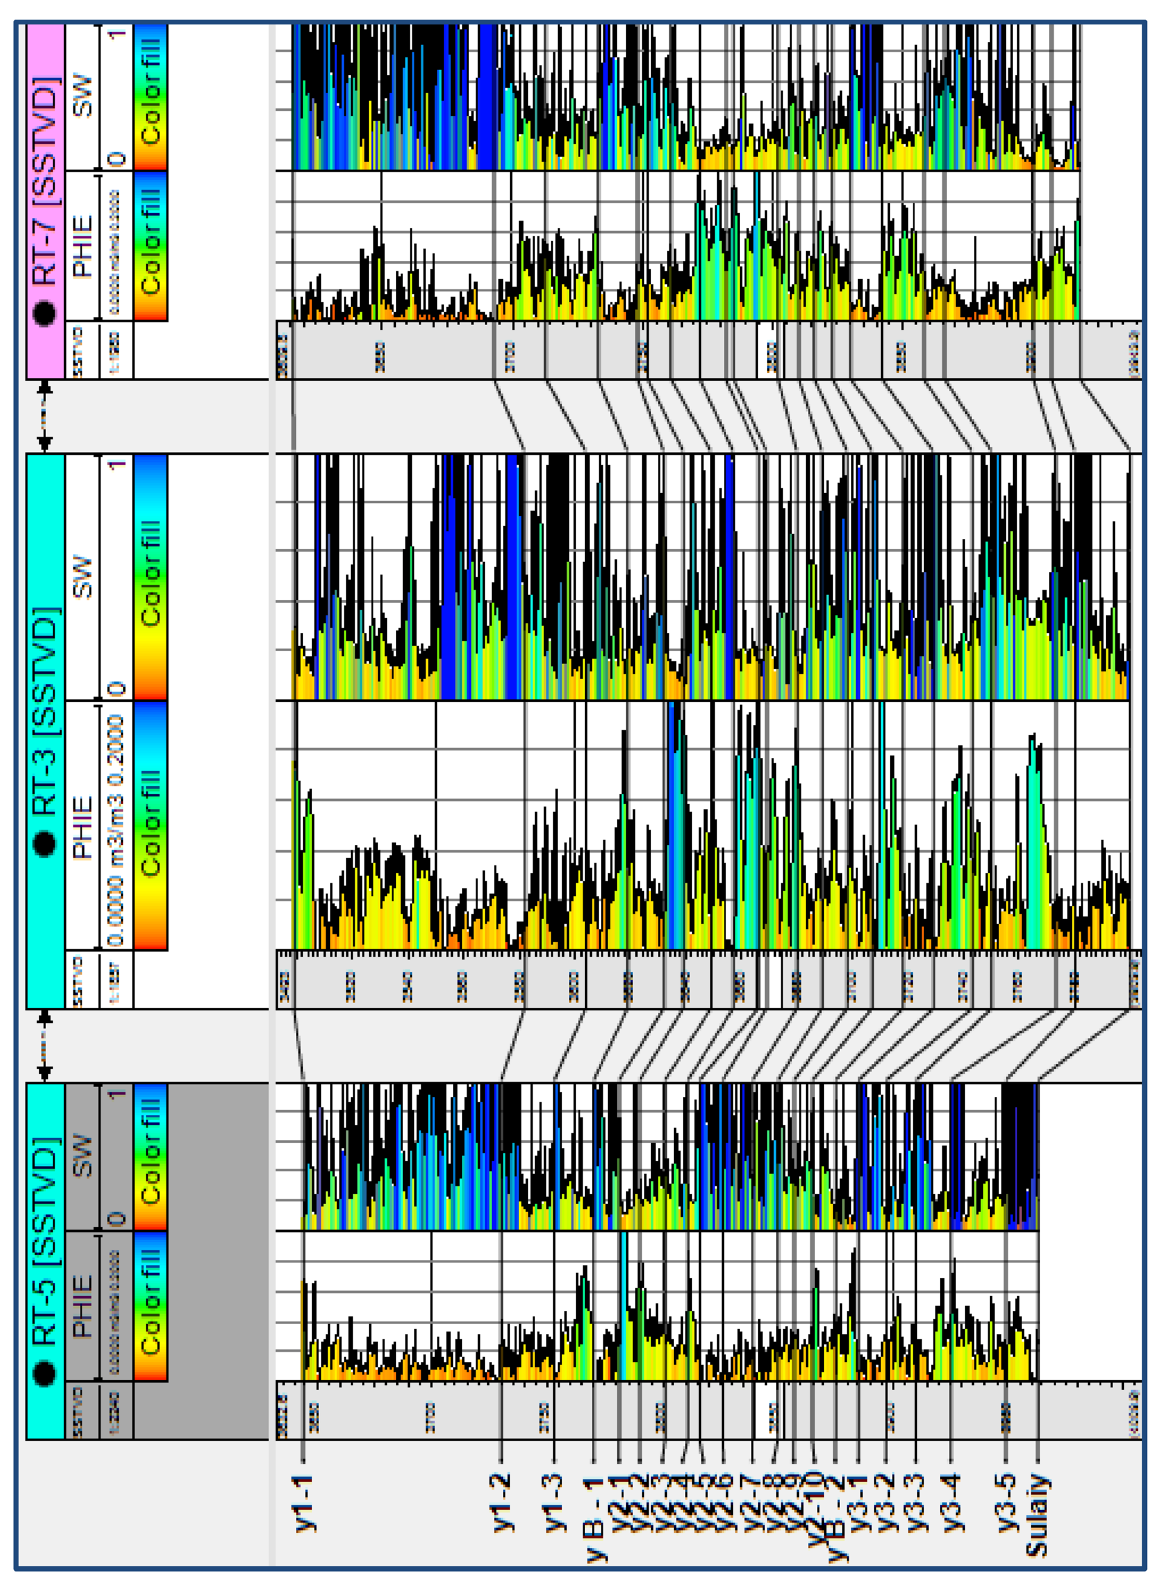
Fig. 8 Porosity and Water saturation section for wells Rt-5, 3, and 7 in Yamama